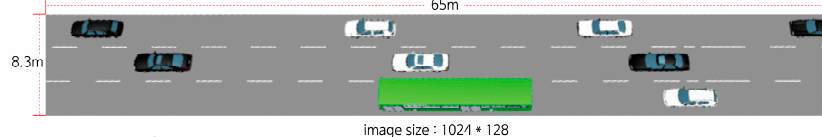
Figure 18. A sample image drawn from the car model provided by Vissim.